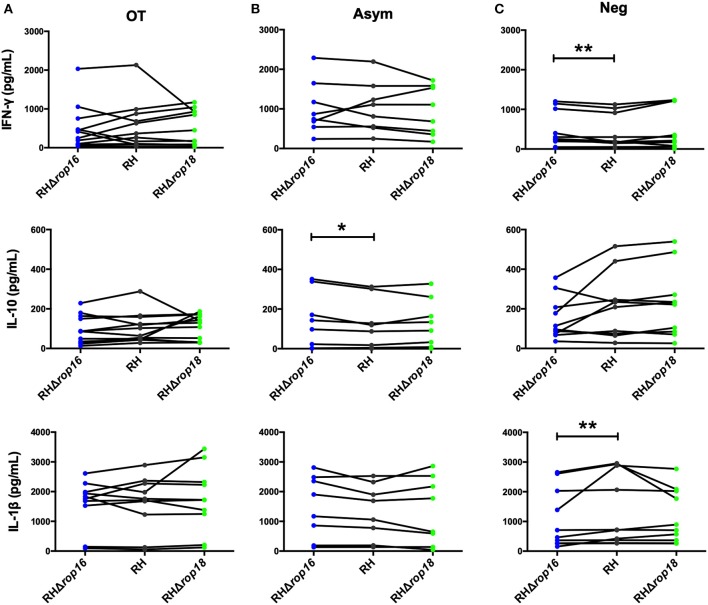
Comparison of cytokine production by PBMCs infected with T. gondii RH, RHΔrop16, and RHΔrop18 in culture supernatants at 24 h. OT (A), Asym (B), and Neg (C). *p < 0.05, **p < 0.01; Wilcoxon signed-rank test. Lines are representative of each individual. OT, Ocular toxoplasmosis; Asym, Chronic asymptomatic infection; Neg, T. gondii seronegative individuals.